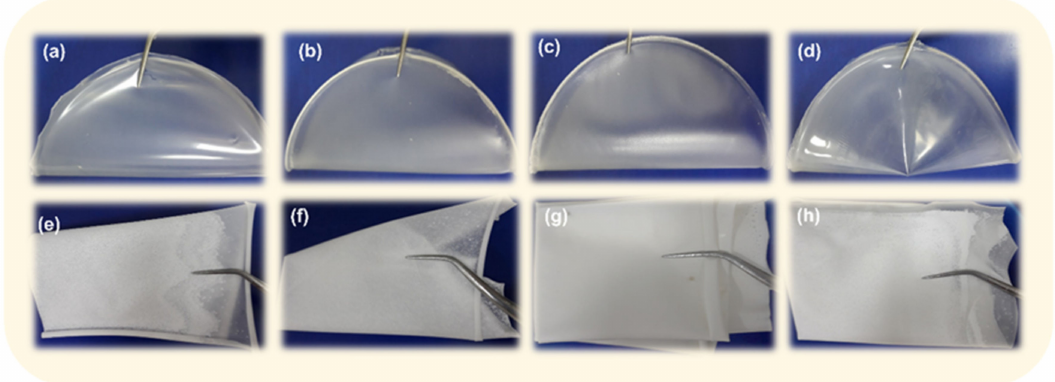
Figure 4. The effect of the casting temperature on the PETU-based membranes prepared by dry solution casting method at: ( a ) room temperature (25 ◦ C), ( b ) 40 ◦ C, ( c ) 60 ◦ C, and ( d ) 80 ◦ C; and in wet solution casting method: ( e ) direct solvent casting at 45 ◦ C, ( f ) 15 min, ( g ) 30 min, and ( h ) 60 min air precoagulation and then immersing in a water bath at 45 ◦